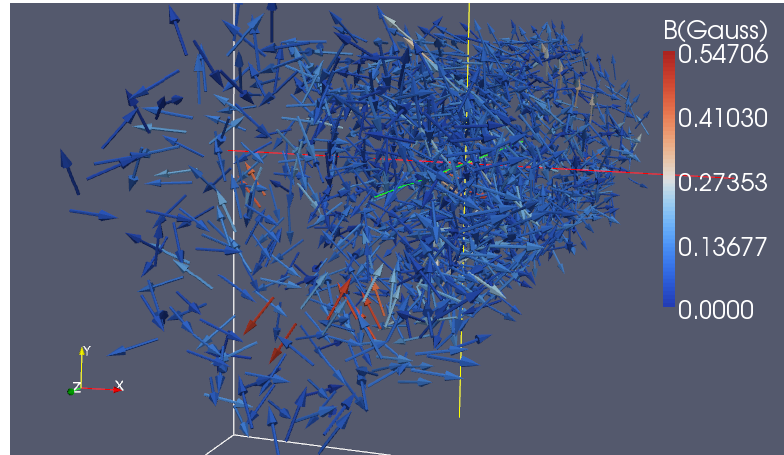
Figure 4. A rendering of the three-dimensional distribution of disordered magnetic field within a turbulent TEMZ grid. As in Figure 2, each vector depicts the magnetic field orientation within an individual plasma cell, and is color-coded according to the strength of the field (see color bar to the